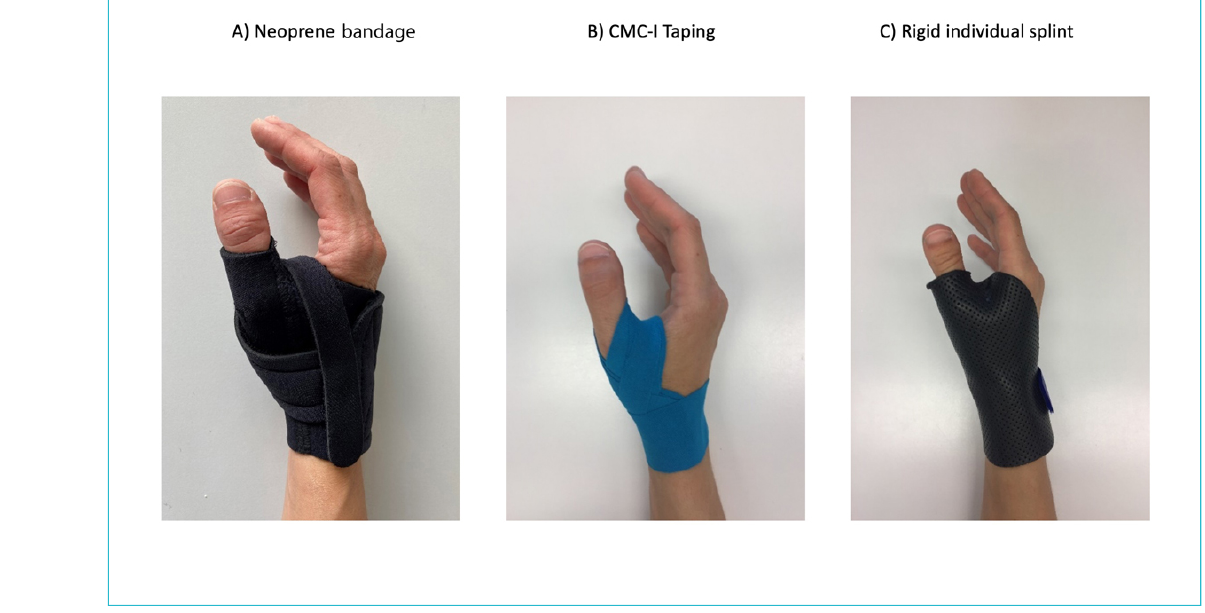
Figure 3: Different splints of the TMC joint. The right splint has to be chosen according to the patient’s needs and demands. Neoprene ban- dages (a) provide a high level of comfort and serve as insulation layer. Taping (b) presents a good alternative, especially for those needing to wear gloves at work (e.g., healthcare professionals). Rigid individual splints (c) provide the highest level of